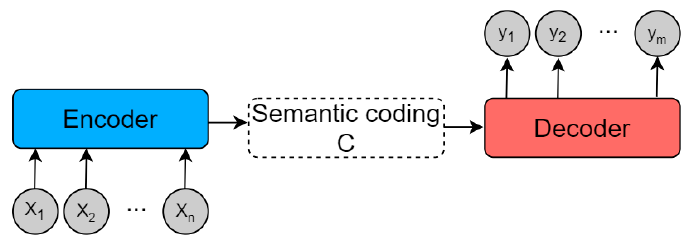
Figure 9. Abstract Encoder-Decoder framework.